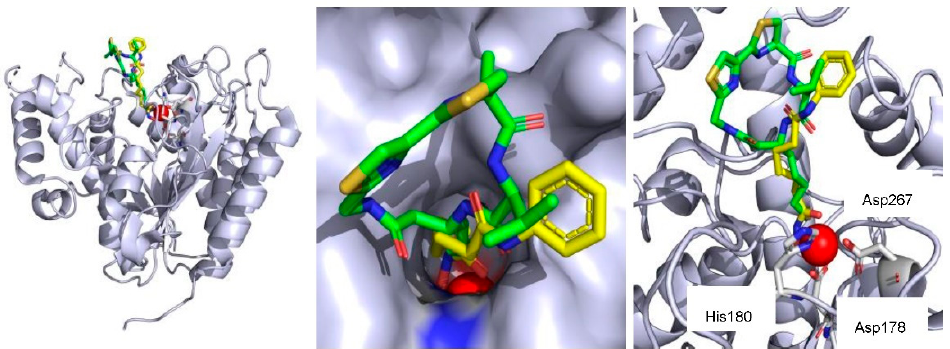
Figure 3. Binding modes of largazole (green) and SAHA (yellow) obtained from the co-crystal structure of HDAC8 complexed with largazole (PDB: 4RN0) or SAHA (PDB: 1T69); Zinc ion (Zn 2+ ) presents as a red ball shape. This figure was generated using Pymol.